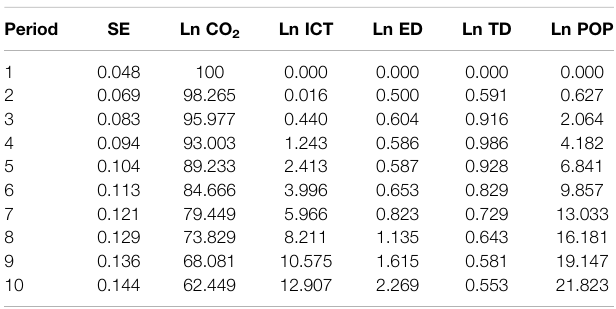
TABLE 5 | Variance decomposition of CO 2